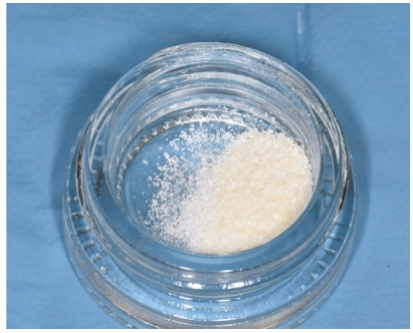
Figure 7. The obtained mineralized dentin graft particles.